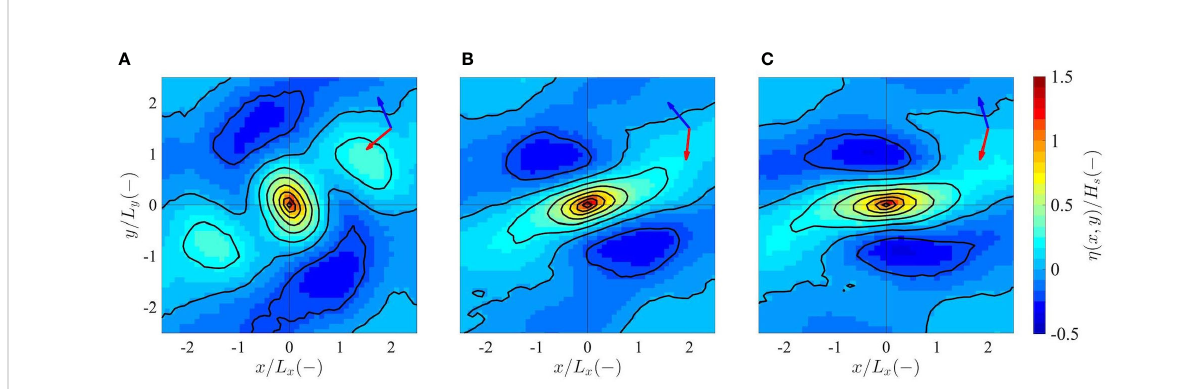
FIGURE 9 Spatial ensemble-average of the normalized sea surface elevation fi eld ( h ( x , y )/ H s ) around the highest crests for the crossing sea states S1 (A) , S2 (B) and S3 (C) , identi fi ed within an area of width X=10L x (a smaller sea surface area centred at the focusing point x/L x = y/L y =0 is displayed). The corresponding wind sea (solid red) and swell (solid blue) mean directions are plotted in the upper right-hand corner, with the x and y axes representing the zonal and meridional directions, respectively. Sea surface elevation isolines are drawn at 0.2 interval.